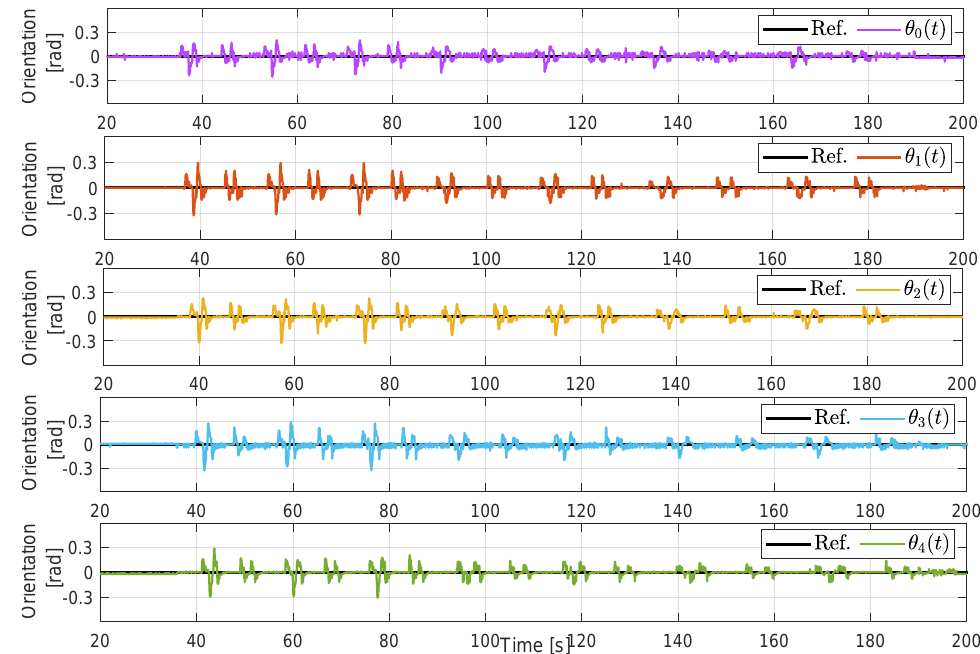
Figure 14. Angle tracking using the cooperative